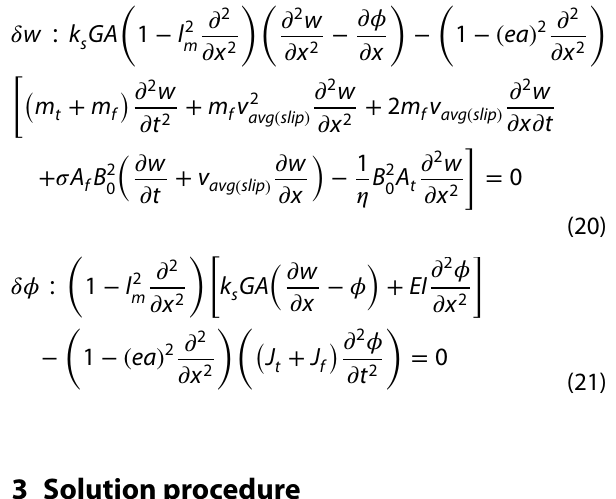
Fig. 2 Comparisons between the phase velocity for wave propa- gation related to SWCNT obtained in the present study with those presented by Wang and Hu [6] for v avg ( slip ) = 0 , Kn = 0 and B 0 =